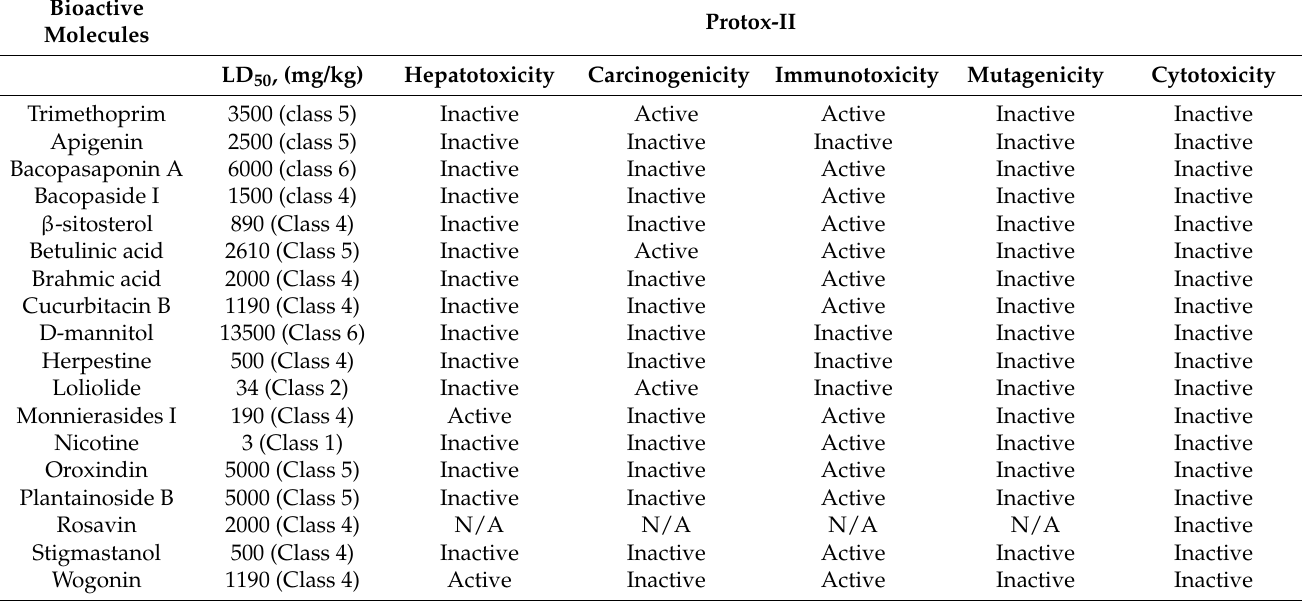
Table 6. Toxicity predictions of major bioactive molecules of B. monnieri and standard drug used for UTIs, based on ADMET SAR and Protox-II